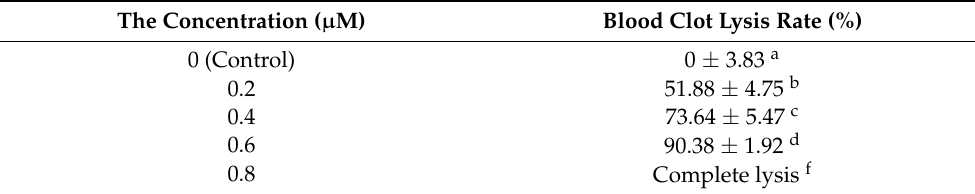
Table 4. The effect of Velefibrinase on the lysis of blood clots.